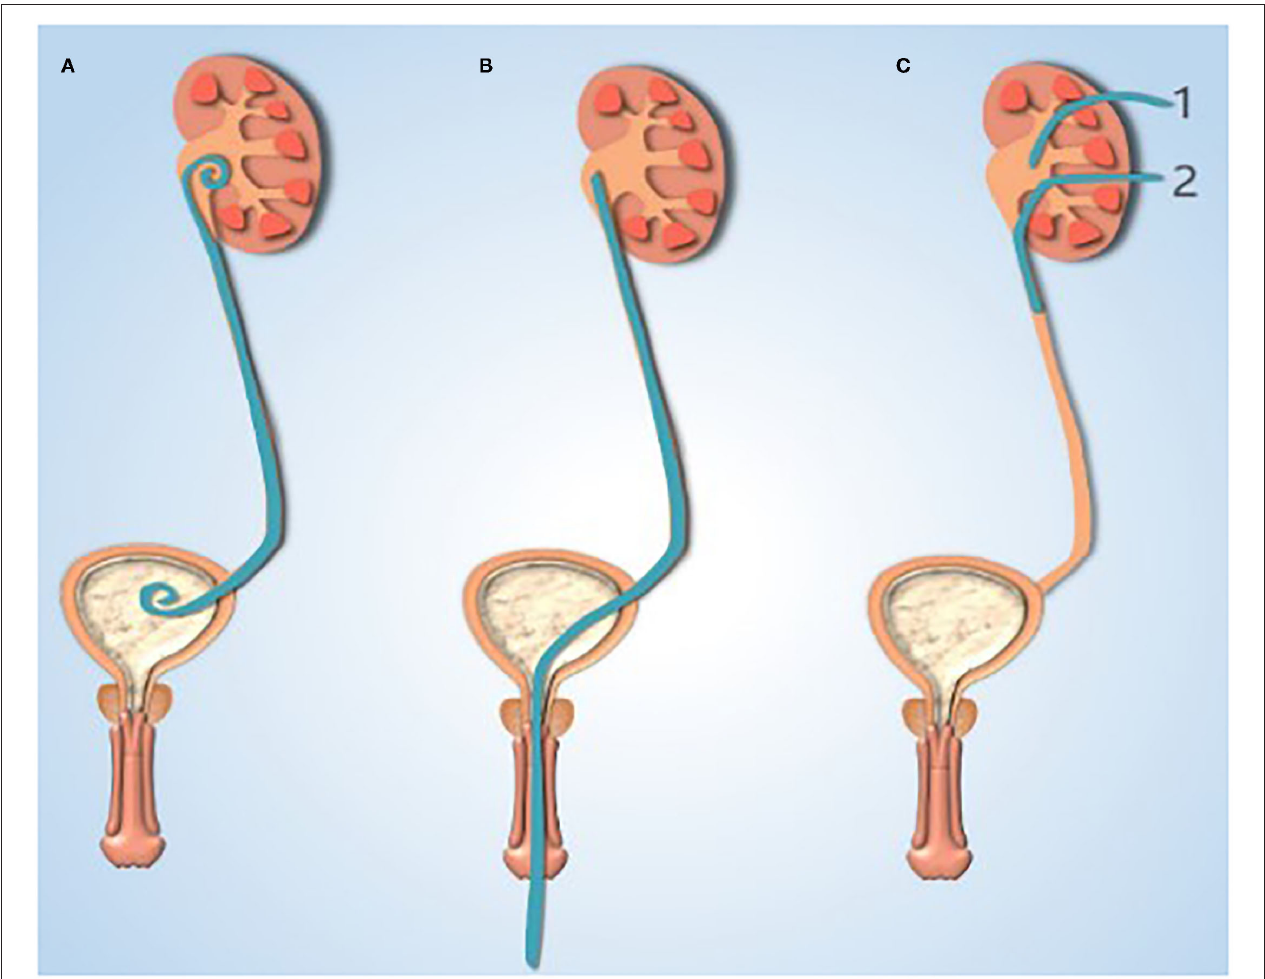
FIGURE 1 | Schematic diagram of three types of postoperative drainage stents. (A) DJ stent. (B) TEUS. (C) PU stent: 1, drainage stent; 2, stent. DJ, double-J stent; TEUS, trans-uretero-cystic external urethral stent; PU, percutaneous trans-anastomotic.